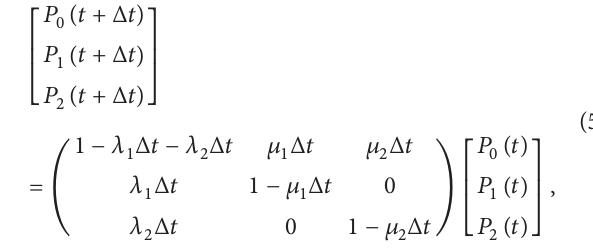
time point 𝑡 𝑘 , and 𝑃 1 (𝑡) is success probability of operator 𝑛 1 at time point 𝑡 .